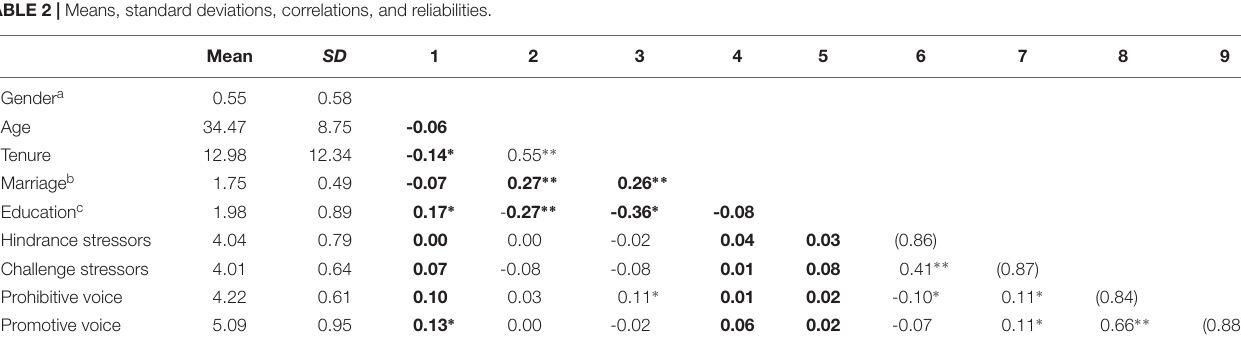
TABLE 2 | Means, standard deviations, correlations, and